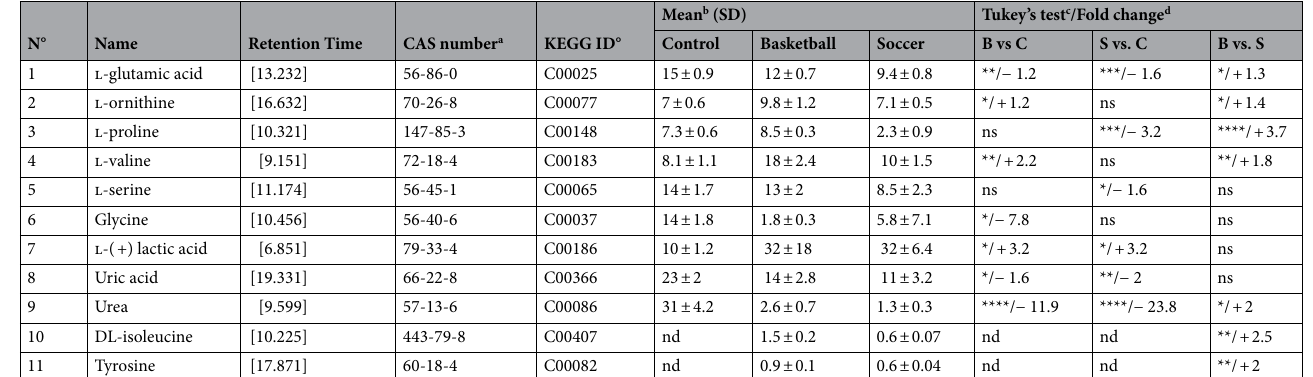
Table 2. List of Metabolites identified in plasma of controls, basketball and soccer players by Gas Chromatography–mass spectrometry (GC–MS) analysis. a Chemical Abstract Service number KEGG identifier (https:// www. genome. jp/ kegg/). b The mean of peak area and the respective SD were obtained by GraphPad Prism 6.0 software using the peak area calculated by Agilent MassHunter Quantitative Analysis B08.00 software. All data were reported in order of magnitude 10–7 (nd = not detectable). c Tukey’s post-hoc test was performed by GraphPad Prism 6.0 software reporting the adjusted p-value (*p-value < 0.05), (**p-value < 0.01), (***p-value < 0.001), (****p-value < 0.0001), (ns = not significant). d Fold change was calculated by GraphPad Prism 6.0 software. It is the ratio of the mean of controls (C), basketball players (B) and soccer players